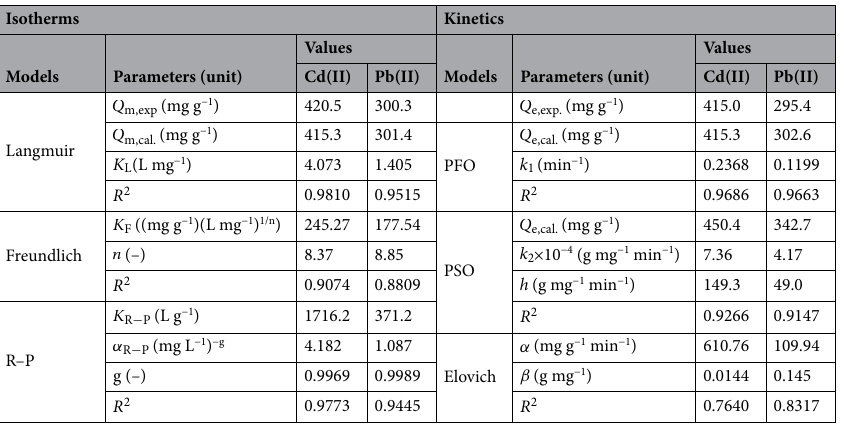
Table 3. The obtained values for isotherm and kinetic parameters using the non-linear fitting